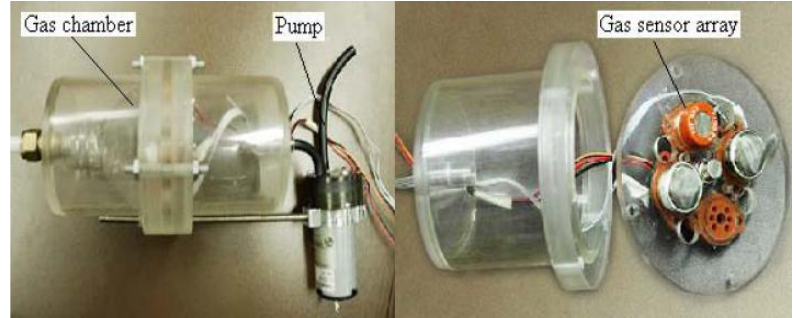
Figure 5. An electronic sensor node designed for the purpose of monitoring odorant gases and accurately estimating odor strength in and around livestock farms (Reproduced with permission from Simon X. Yang, Sensors, published by MDPI, 2009)